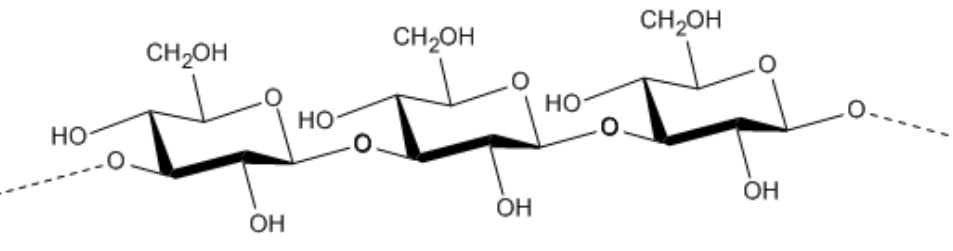
Figure 5. Chemical structure of curdlan